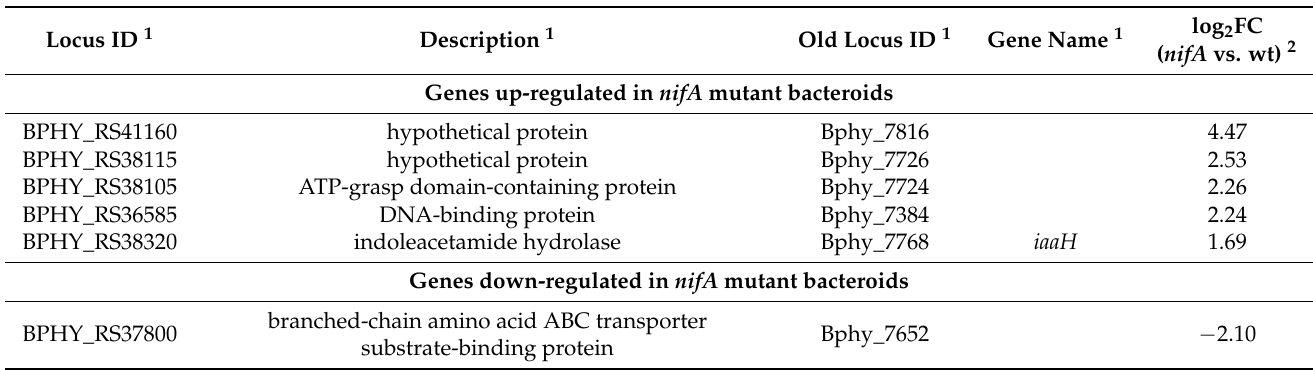
Table 1. List of the 142 genes located in P. phymatum STM815 symbiotic plasmid (pBPHY02) that showed a differential expression in common bean nodules infected with nifA mutant strain compared to the wild-type nodules (abs[log 2 (fold- change)] ≥ 0.5 and p -value ≤